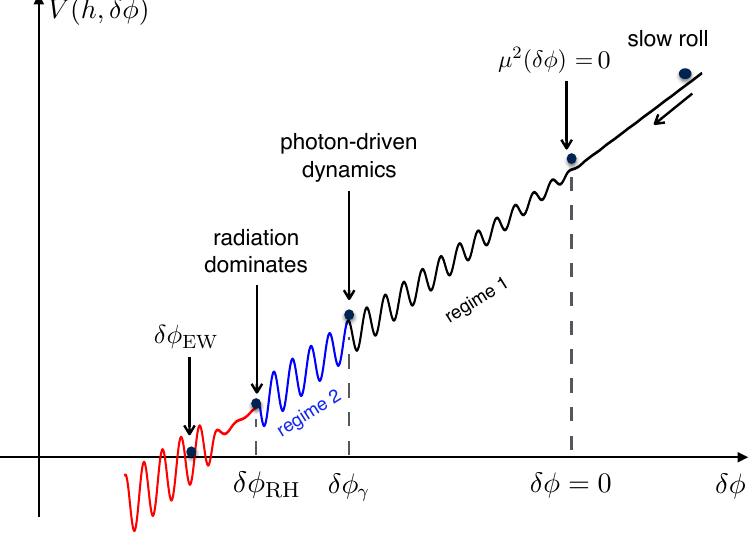
Figure 1 . Sketch of the di(cid:11)erent stages in our relaxation mechanism. The (cid:12)rst ( black ) is the standard slow-roll regime, as described in subsection 4.2. In the second ( blue ), the photons are responsible for the dissipation in the in(cid:13)aton/relaxion dynamics, which is discussed in subsection 4.3. Finally, the last stage of relaxation occurs after reheating ( red ), with the photons still providing dissipation and allowing the relaxion to get trapped in the wiggle potential (see subsection 4.4). density of the universe is dominated by V ( h; (cid:14)(cid:30) ), the Friedmann equation